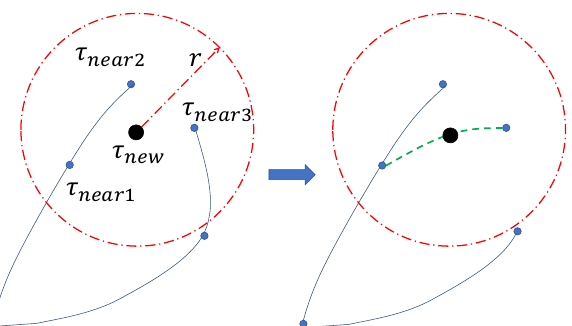
Figure 6. Illustration of rewiring. On the left, three vertices are in the neighbourhood of τ new . τ near 3 is rewired to τ new as the residual energy via the corresponding path is larger, and the odd edge is removed. The new tree is shown on the right.